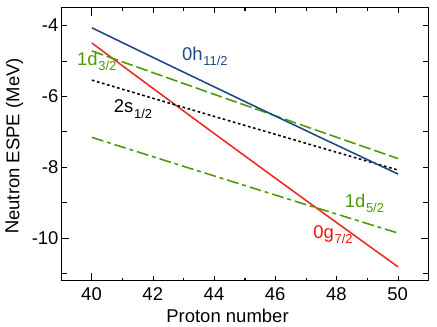
Figure 2. Neutron ESPEs of N = 82 isotones. The blue solid, red solid, green dashed-dotted, green dashed, and black dotted lines denote the ESPEs of the neutron 0 h 11 / 2 , 0 g 7 / 2 , 1 d 5 / 2 , 1 d 3 / 2 , and 2 s 1 / 2 orbits.